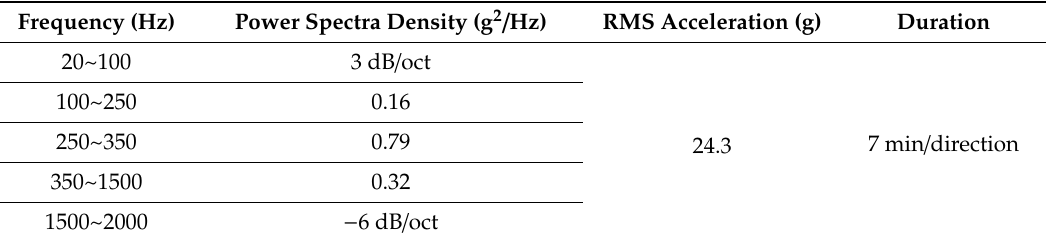
Table 2. High frequency random vibration condition 2.